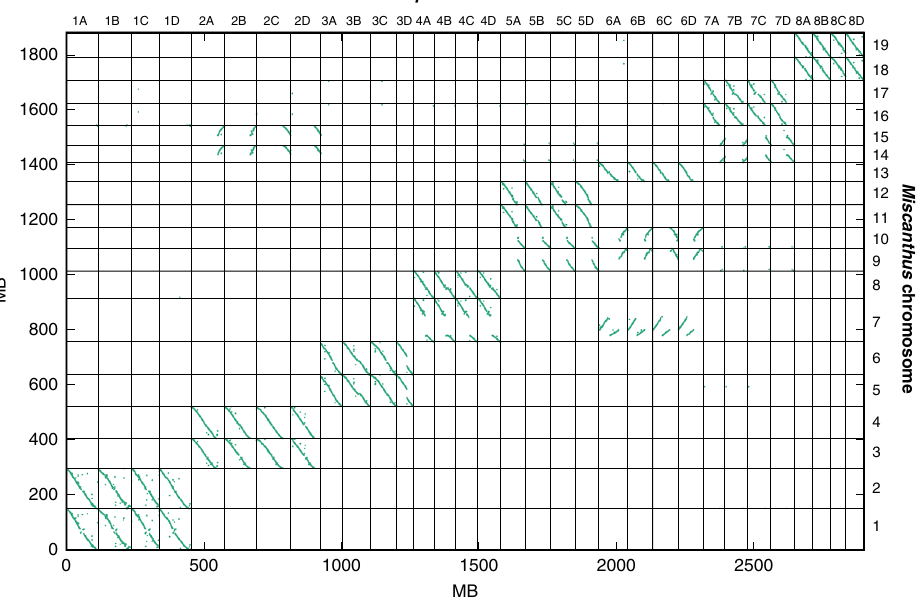
Fig. 2 Miscanthus – Saccharum synteny. Dotplot showing co-orthologs between Miscanthus sinensis and Saccharum spontaneum . All syntenic genes with c score ≥ 0.7 are shown using the mcscan ortholog algorithm. Note the 2:4 ratio of miscanthus:sugarcane chromosome segments. Source Data are provided as a Source Data fi le.